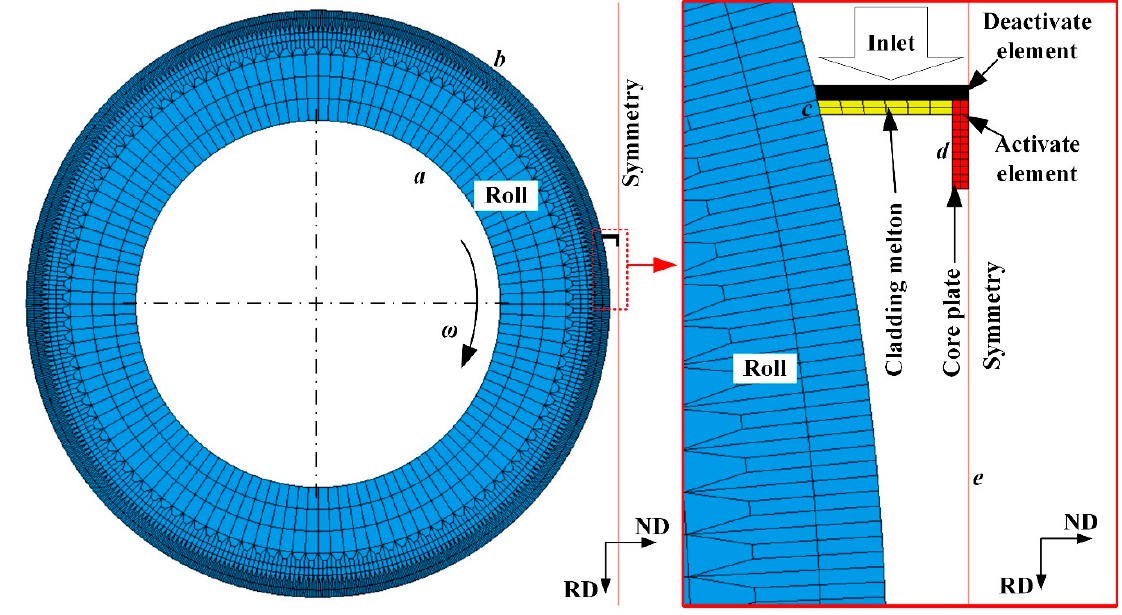
Figure 10. Mesh model of LSL-TRC for three-laminated aluminum composite plate.